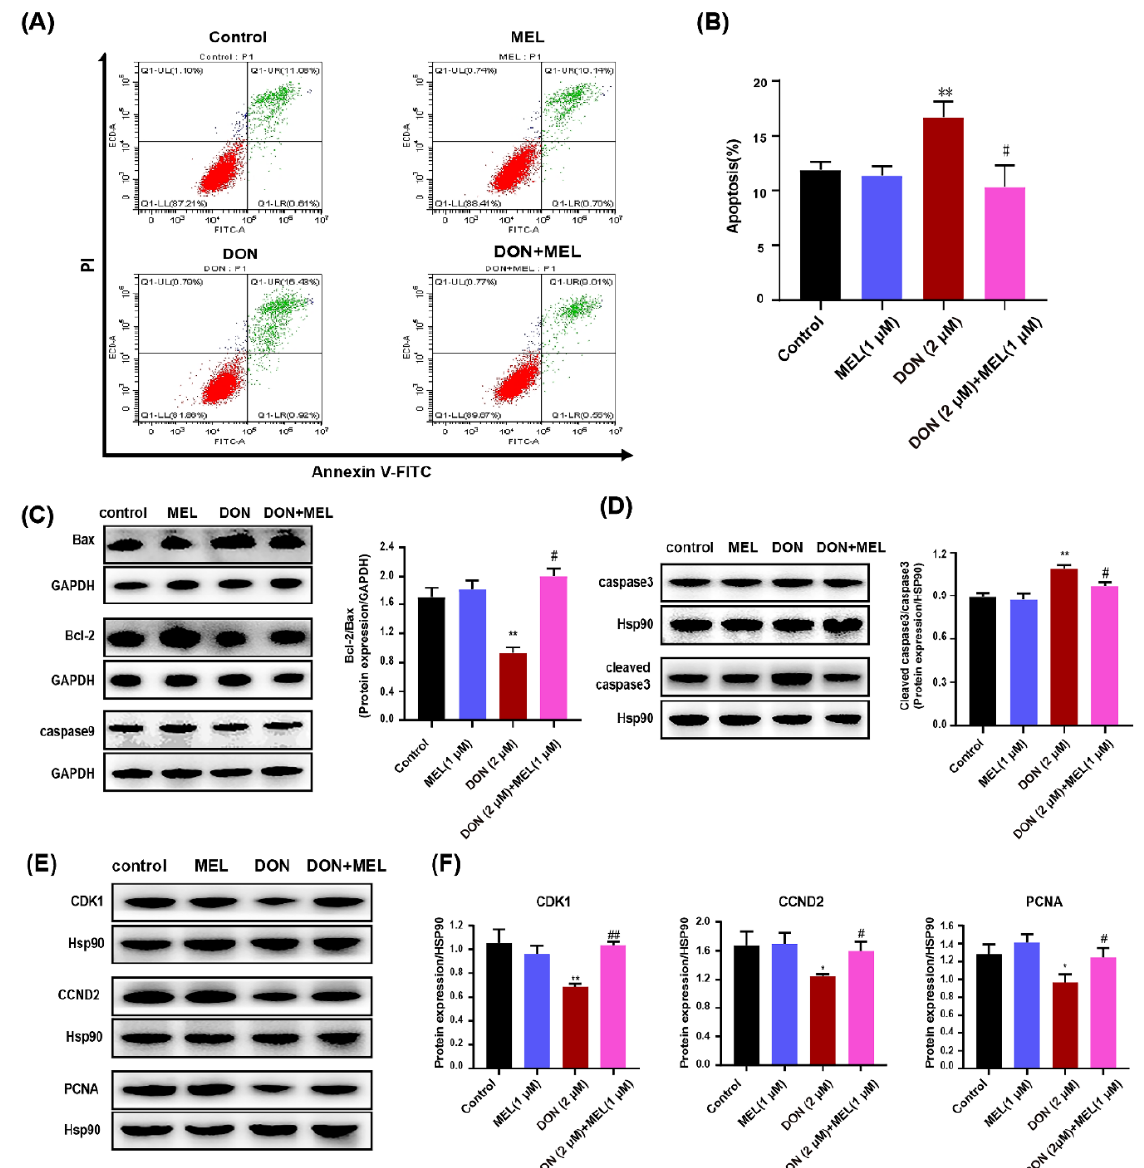
Figure 2. Melatonin treatment ameliorates DON-induced mouse ovary GC apoptosis. ( A ) Apoptosis of GCs was evaluated by measurement of Annexin V using flow cytometry. Apoptotic cells were Annexin V-positive and PI (propidium iodide)- negative. ( B ) The figure shows representative staining, and the numbers in the quadrants indicate the percentage of cells within the respective subpopulations. ( C , D ) Western blotting analysis of the changes in the protein levels of related apoptosis factors (Bax, Bcl-2, cleaved caspase-3, caspase-3, caspase9). ( E , F ) Western blotting analysis of the changes in the protein level of functional genes linked to proliferation (PCNA, CDK1, and CCND2). Each bar represents the mean ± SD from three different experiments, n = 3. * p < 0.05 and ** p < 0.01 compared with the control and melatonin (MEL) groups; # p < 0.05, ## p < 0.01 compared with the DON group. MEL: melatonin.